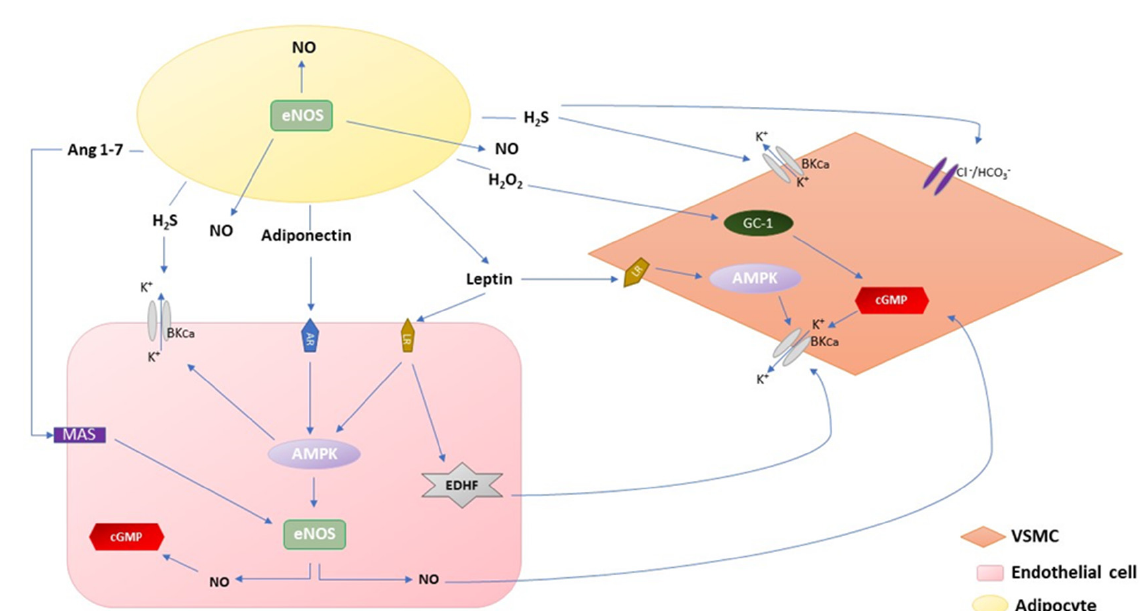
Figure 1. Vasodilatory and hyperpolarizing effect of perivascular adipose tissue–derived factors (PVAT-derived factors) on vascular smooth muscle cells (VSMCs) and hyperpolarizing effect of PVAT-derived factors on endothelial cells. Adiponectin causes vasodilation by affecting adiponectin receptors (AR) in endothelial cells, which contributes to the activation of locations 5 ′ adenosine monophosphate-activated protein kinase (AMPK), which is responsible for the activation of endothelial NO synthase (eNOS). Enhanced NO concentration induces activation of cyclic guanosine monophosphate (cGMP), which is responsible for opening large-conductance calcium-activated potassium channels (BKCa). eNOS is present in both endothelial cells and adipocytes. Leptin activates leptin receptors (LR), which are responsible for activation of not only AMPK, but also endothelium-derived hyperpolarizing factor (EDHF), which activates BKCa. Moreover, AMPK independently activates BKCa and induces a hyperpolarization effect. Hydrogen sulfide (H2S) induces activation of BKCa in VSMCs and endothelial cells. Moreover, it induces a decrease in intracellular pH by the activation of Cl − /HCO3 − ionic exchanger. Angiotensin 1–7 (Ang 1–7) by affecting endothelial Ang 1–7 receptor (MAS) activates eNOS and increases the NO concentration. Hydrogen peroxide (H 2 O 2 ) stimulates the soluble guanylyl cyclase (sGC-1), which induces